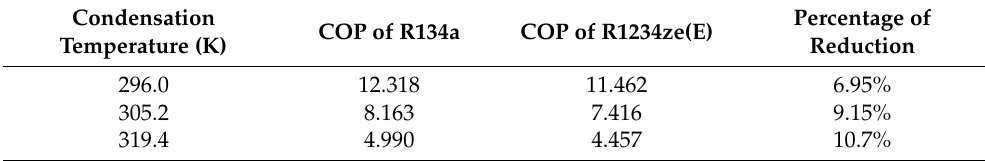
Table 6. COP comparison of R1234yf unit and R134a unit.